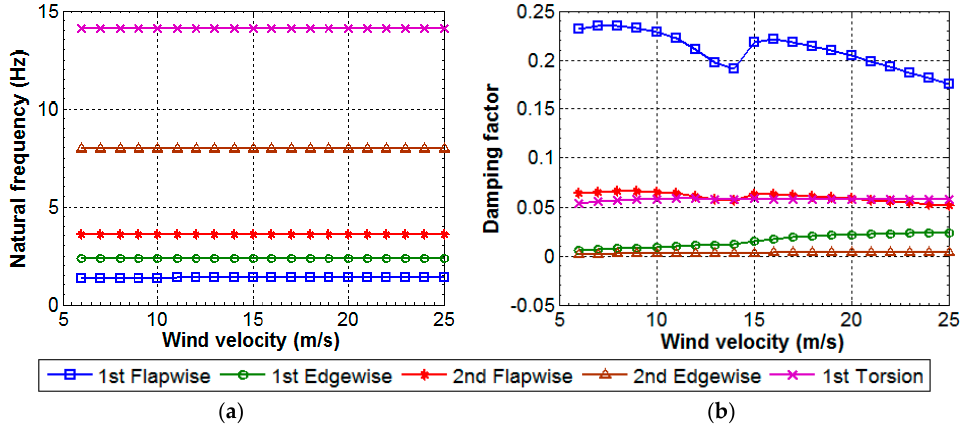
Figure 6. Aeroelastic ( a ) natural frequencies and ( b ) damping factors without ice on the blade.